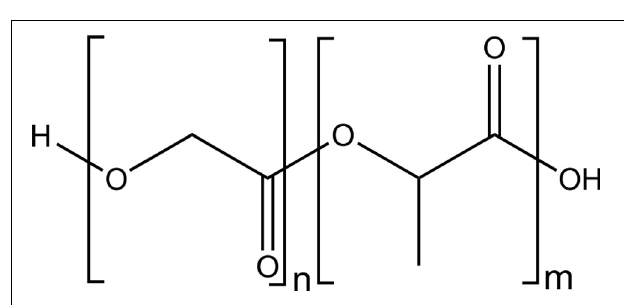
FIGURE 3 | Structure of poly(lactic acid- co -glycolic